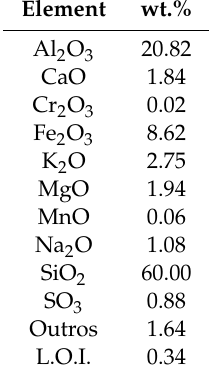
Table 2. Chemical composition of the fly